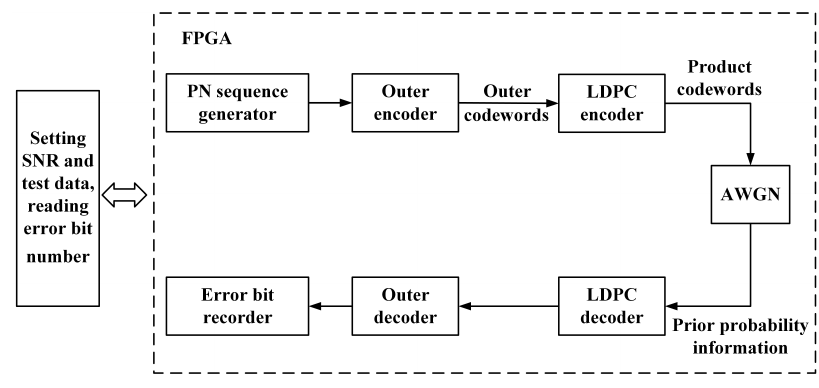
Figure 9. The hardware evaluation platform.